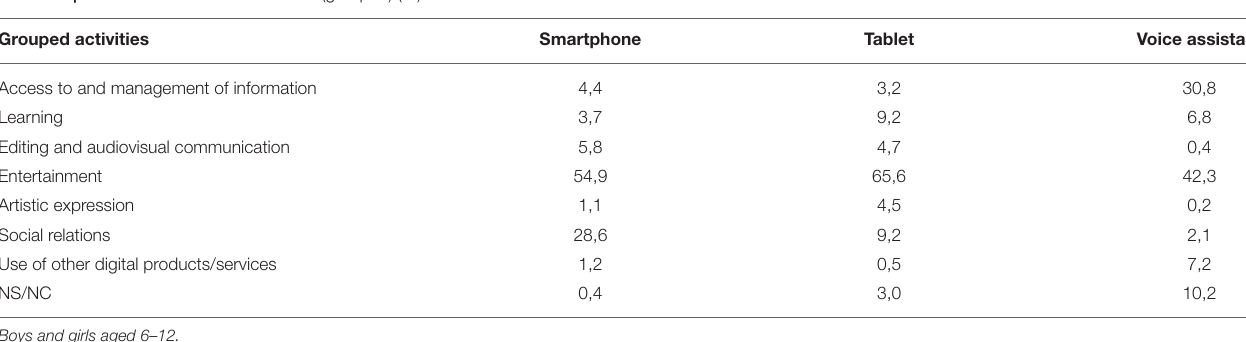
TABLE 5 | Favourite activities with devices (grouped) (%). Grouped activities Tablet